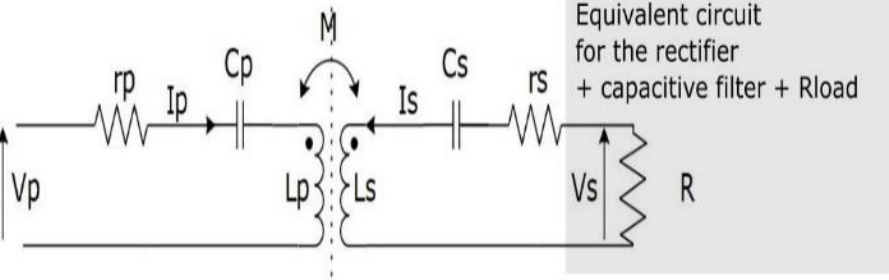
Figure 3. Coupler model with series–series compensation with one transmitter and one receiver. Table 2. Parameter’s definition .